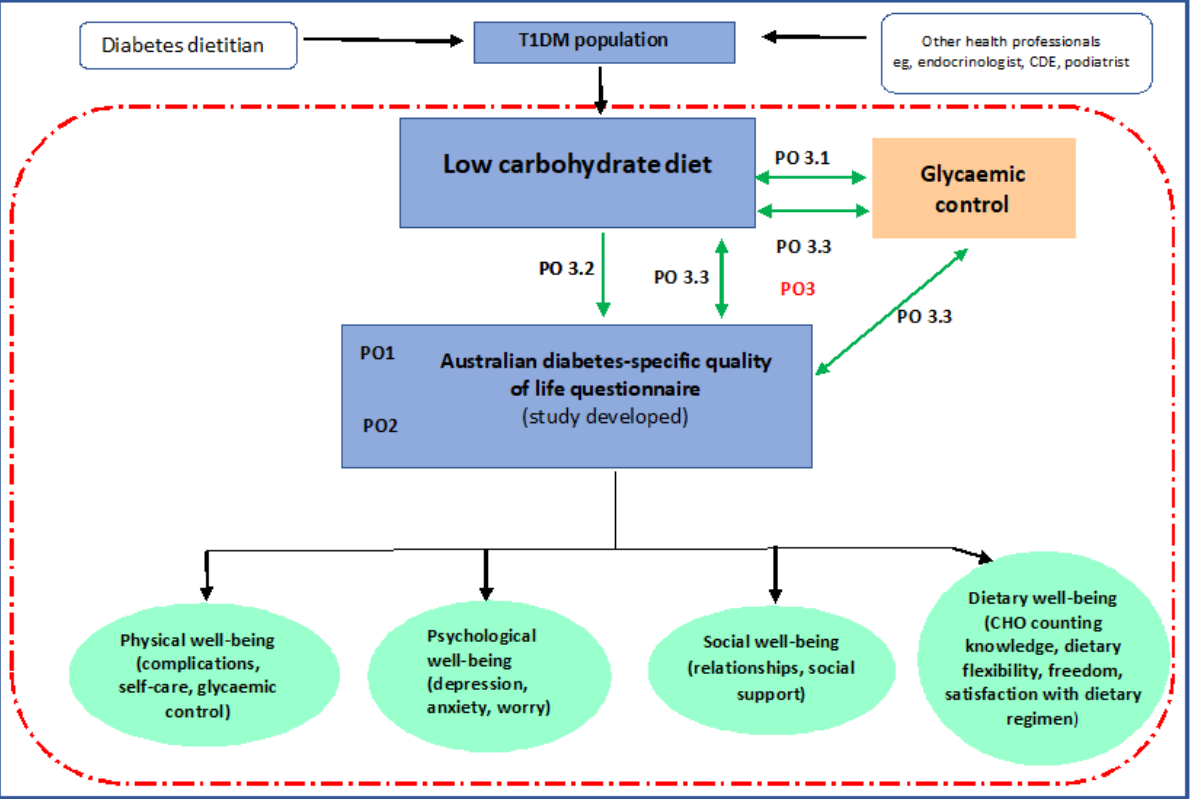
Figure 1. The association between adults living with type 1 diabetes mellitus, quality of life, and glycemic control. CDE: credentialed diabetes educator; CHO: carbohydrate; PO: primary outcome; T1DM: type 1 diabetes